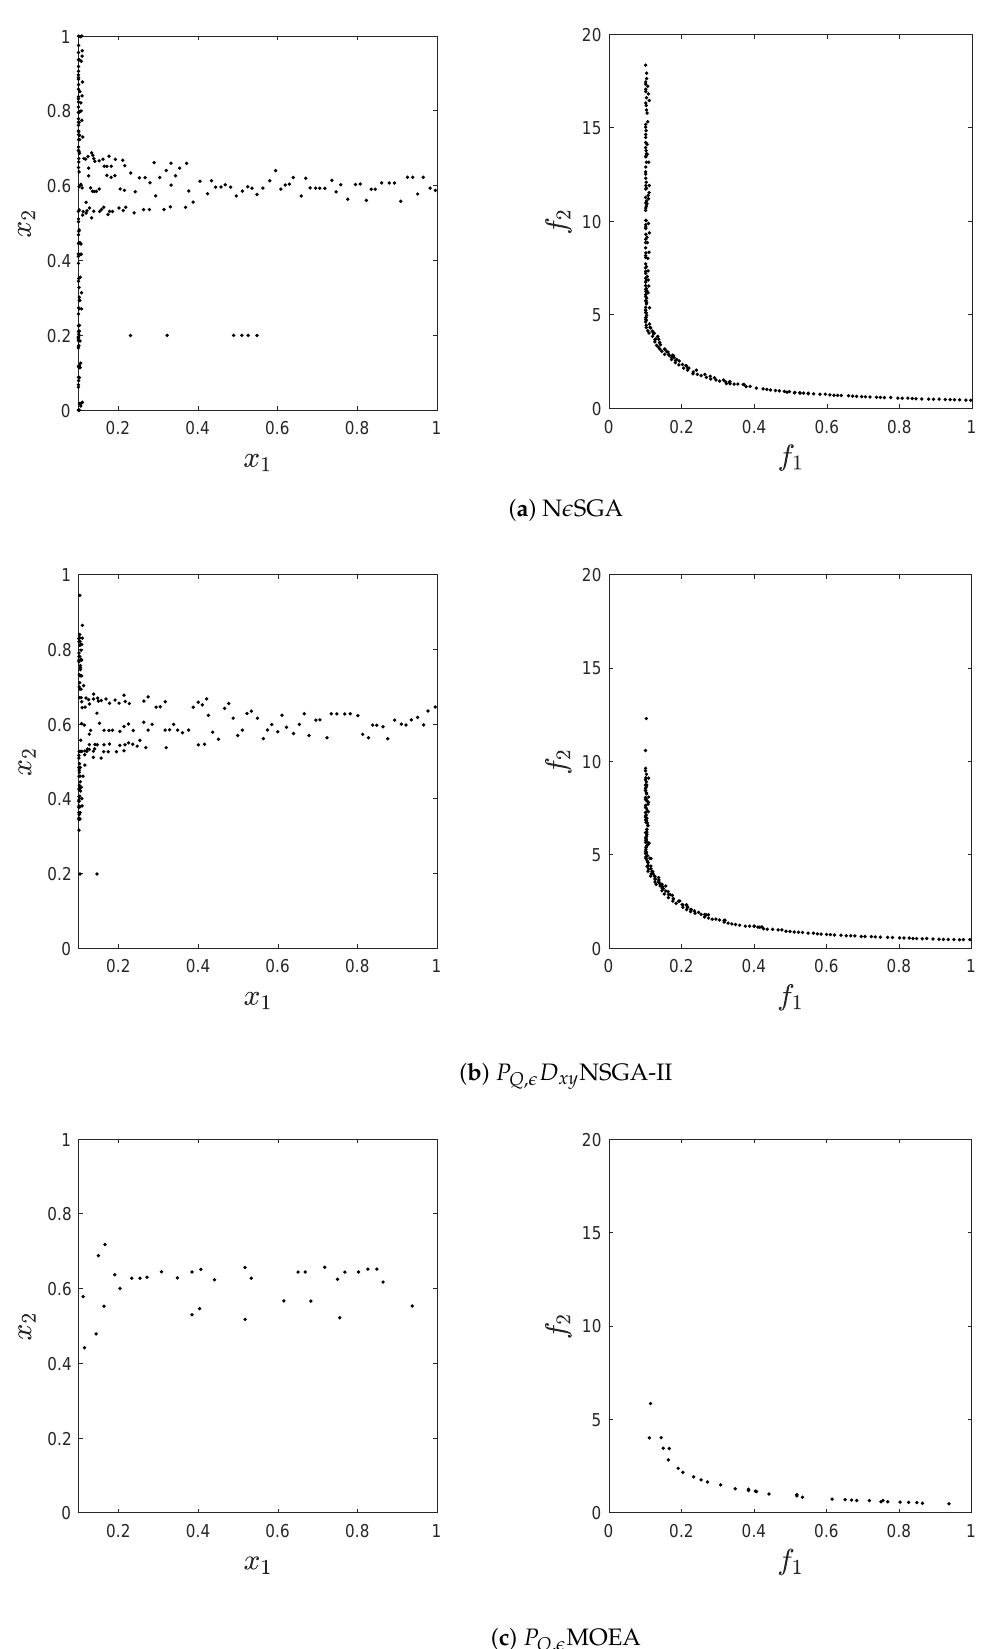
Figure 4. Numerical results on Deb99 for the comparison of N e SGA2 and the state-of-the-art algorithms.